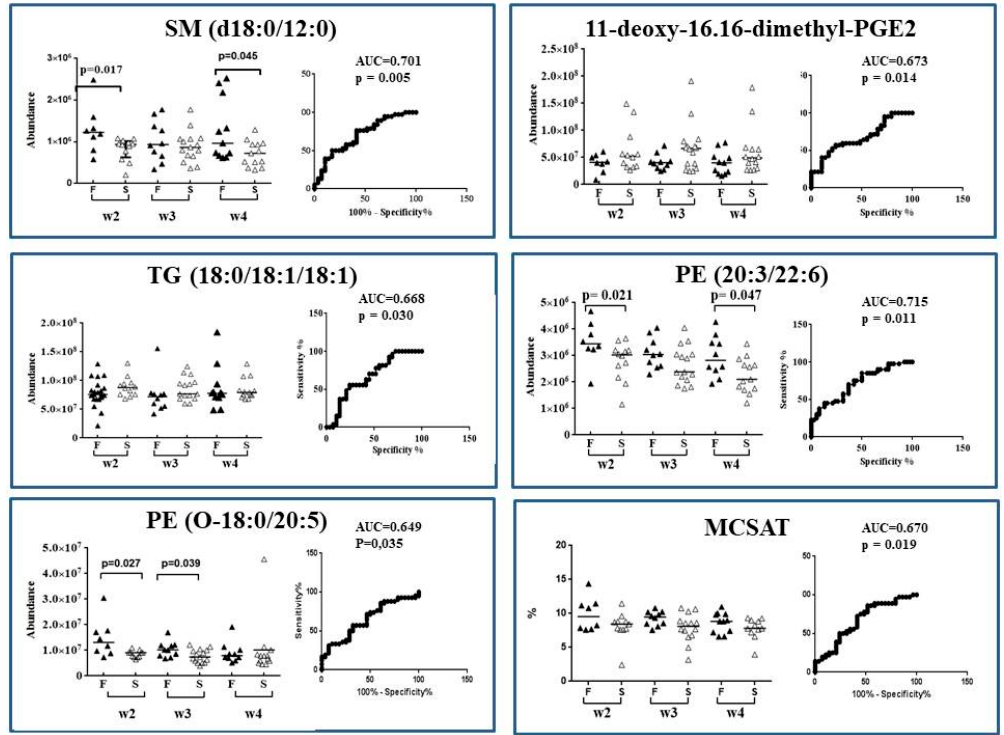
Figure 5. Scatter plot and ROC plot analysis using lipids biomarkers abundance (SM (d18:0/12:0), TG (18:0/18:1/18:1), PE (O-18:0/20:5), PE (20:3/22:6), MCSAT and one deoxy-dimethyl-PGE2) in breast milk provided to preterm infants who experienced “faster” (black triangle, F group) versus “slower” (white triangle, S group) growth during hospital stay. Scatter plot (median): from w2 to w4 of lactation period; ROC plot: over the entire W2–W4 lactation period. ▲ Faster growth group (F); Δ slower growth group (S).